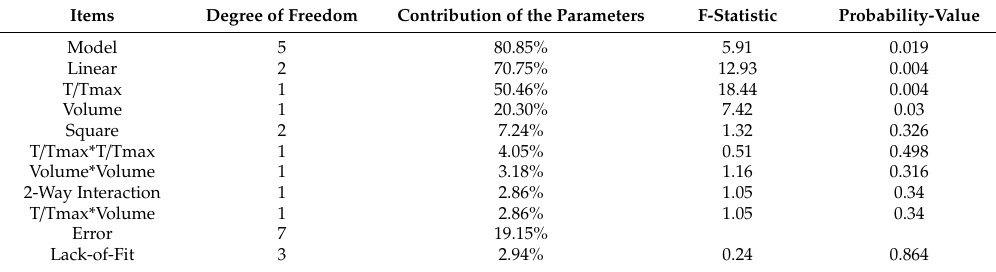
Table 4. ANOVA analysis for the thermal